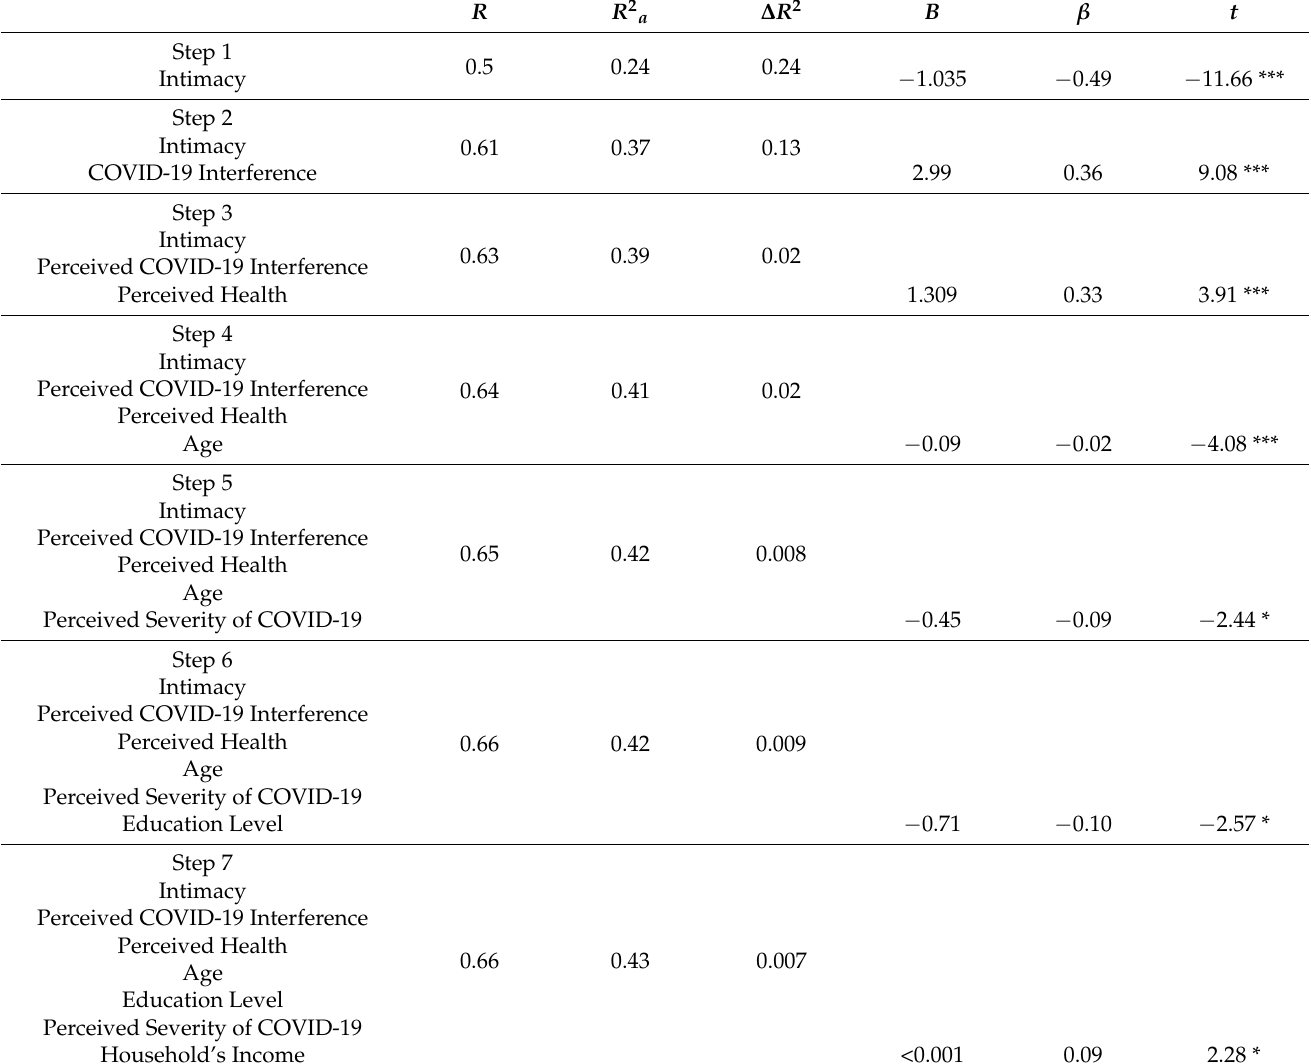
Table 3. Stepwise multiple regression analysis explaining depression.